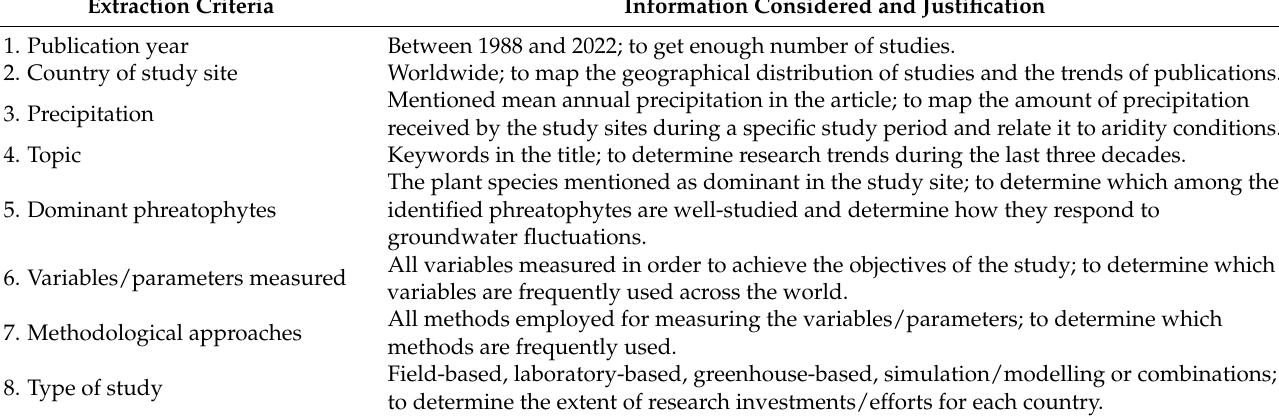
Table 2. The criteria used for the extraction of information from the selected peer-reviewed original and review